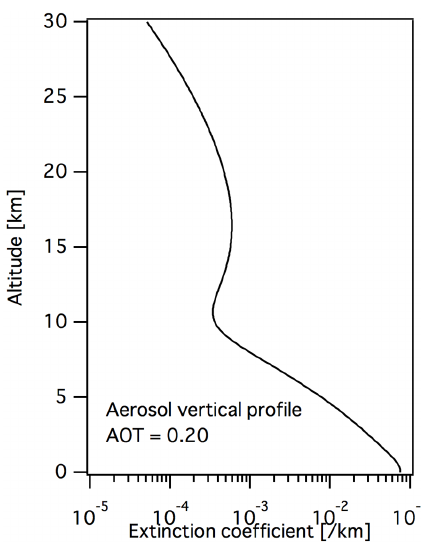
Figure 3. A prior vertical profile of aerosol extinction